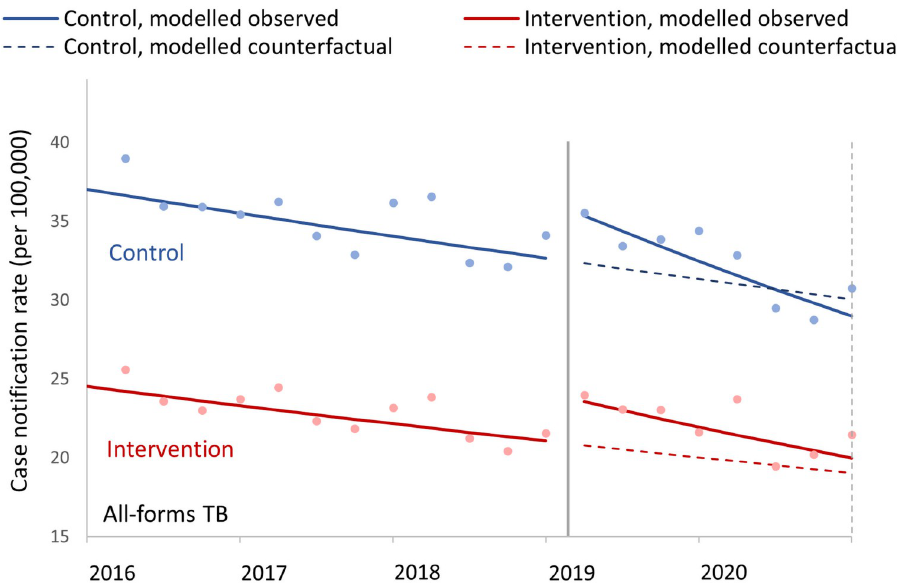
Fig 3. Controlled interrupted time series analysis model graphs of population-standardized quarterly tuberculosis notification rates. All forms TB case notification rates for intervention and control populations; from Q1 2016 to Q4 2020, with intervention start in Q1 2019. The observed data points are shown with dots, and the lines are modelled data, with solid lines for modeled observed data and dashed lines for the counterfactual models based on pre- intervention trends; the modelled trend and level changes are shown in Table 3. The solid vertical line indicates the start of the intervention and the dotted vertical line shows the final quarter included in the analysis (Q4 2020), which was used for the calculations in Table